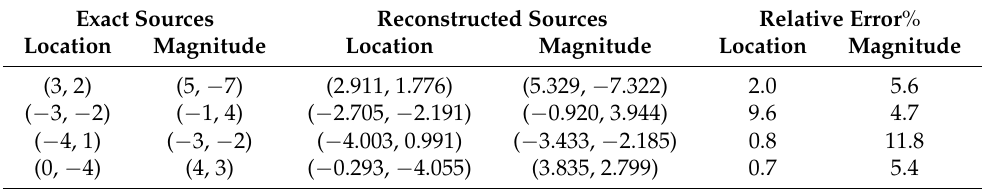
Table 4. Using the least-squares method to reconstruct four single sources from far-field data in 2D.